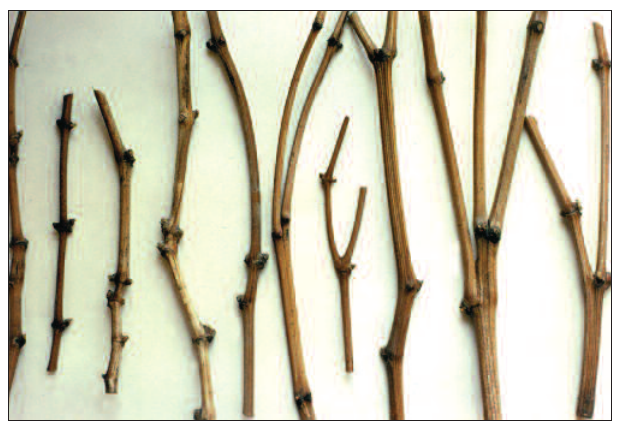
Figure 1. Fanleaf (GFLV) – atipical chronic symptoms in Vitis vinifera canes – malformation, short internodes, double nodes, etc.